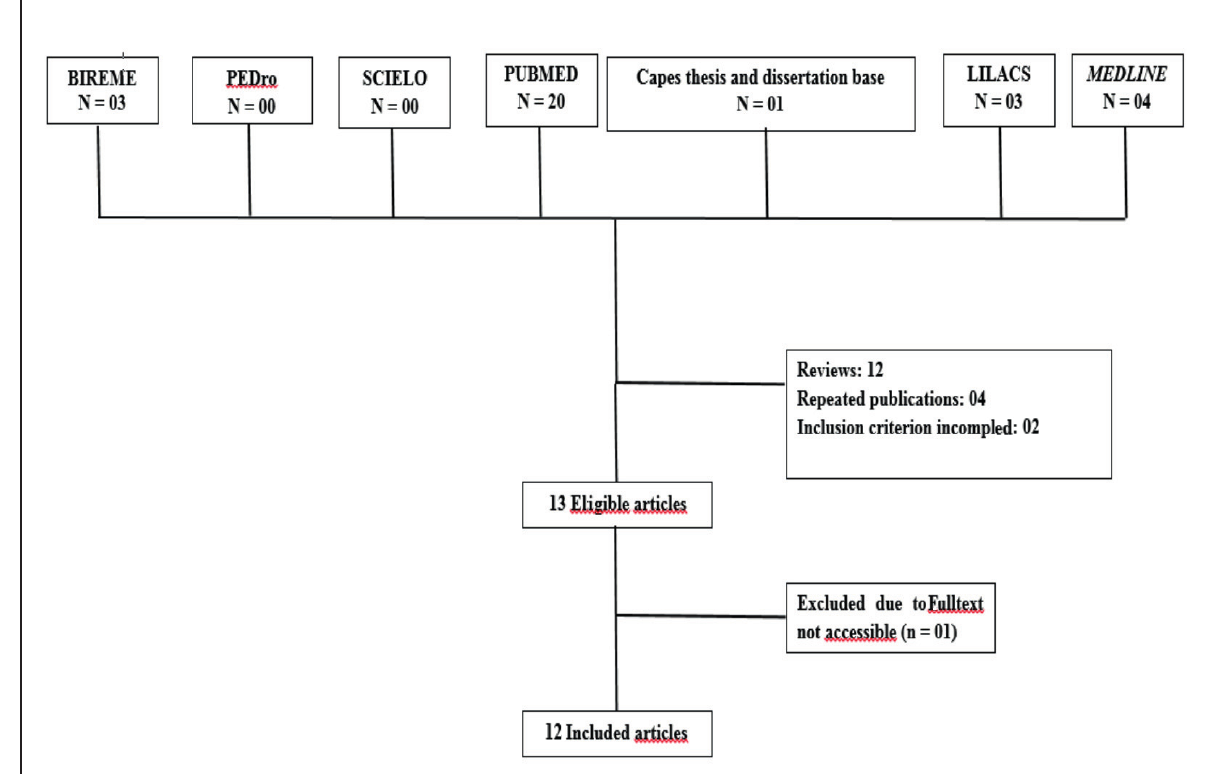
Figure 1 - Flowchart of selected